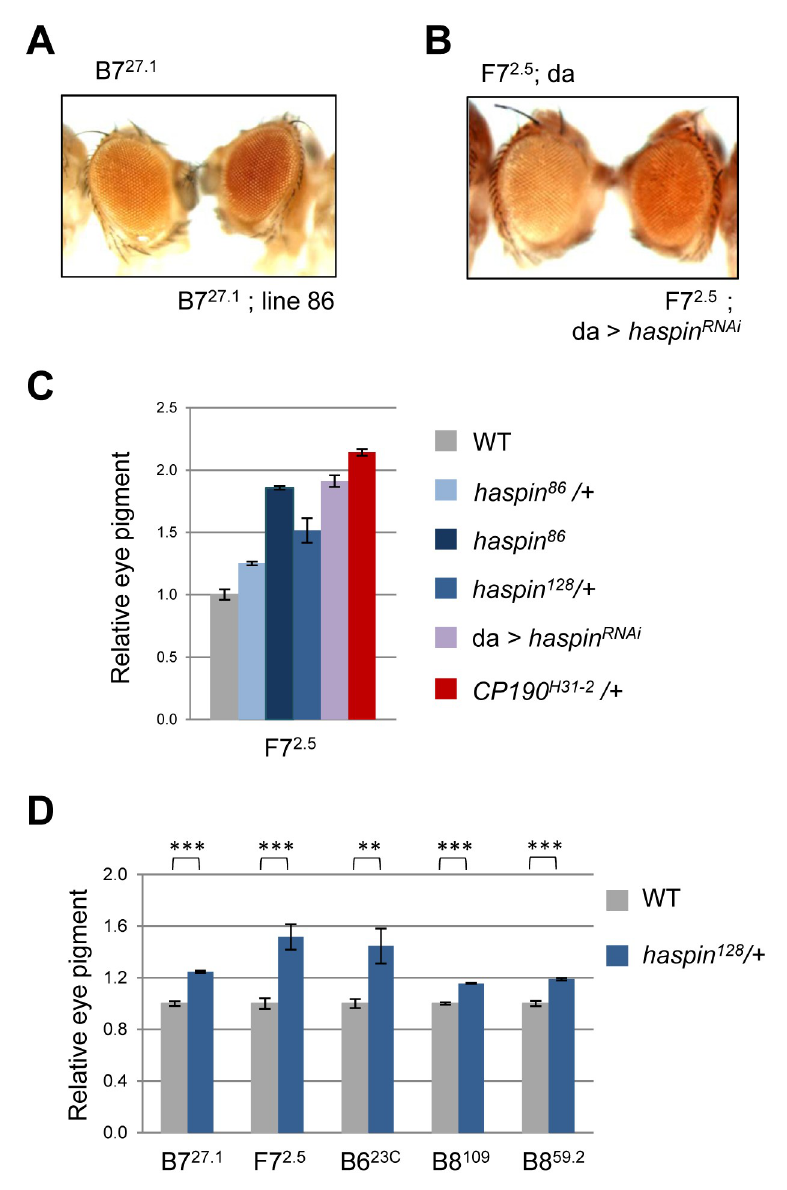
Fig 1. Insulator activity of haspin. A) Eye color of representative flies of enhancer-blocking assays using the transgenic line B7 27.1 that contains the Fab7 insulator element in wild-type and heterozygous line 86 background. B) Eye color of representative flies of enhancer-blocking assays using the transgenic line F7 2.5 that contains the Fab7 insulator and PRE elements in haspin RNAi mutant background. C) Quantitative analysis of eye pigment in flies with the F7 2.5 construct and the genotypes indicated. n = 3, significant differences between wild-type and the different mutant backgrounds as determined by Student’s t -test (p < 0.001). D) Quantitative analysis of eye pigment in flies with constructs containing Fab6 , Fab7 and Fab8 insulator elements (see S1 Fig for details of the constructs) in wild-type and haspin 128 heterozygous mutant background (n = 3). Statistical significance ( �� p < 0.01 and ��� p < 0.001) was determined by Student’s t